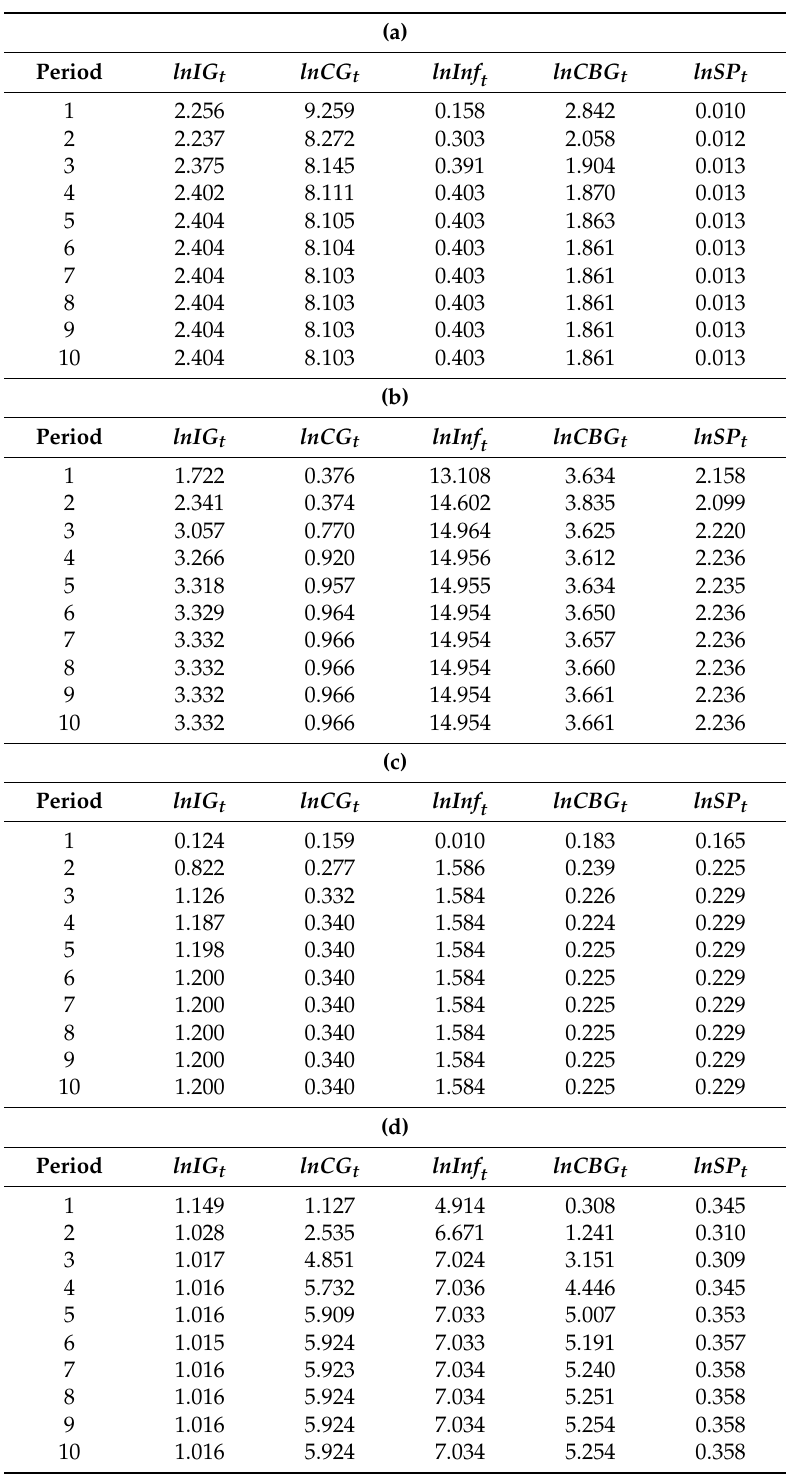
Table 2. India. ( a ) Variance Decomposition of Domestic EPU. ( b ) Variance Decomposition of USA EPU. ( c ) Variance Decomposition of UK EPU. ( d ) Variance Decomposition of Europe